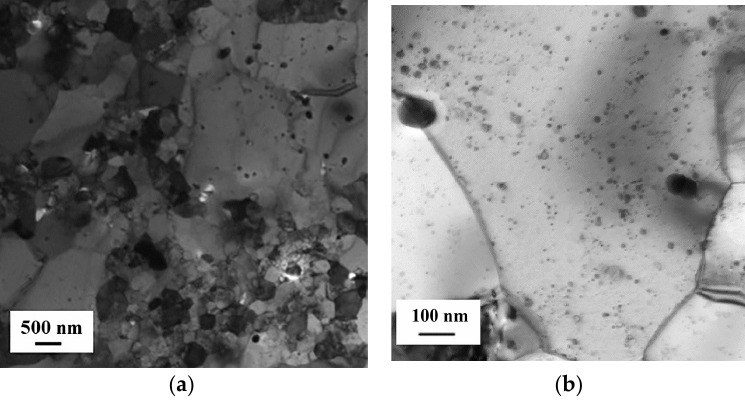
Figure 6. TEM micrograph of ODS sample after heat treatment at 1150 °C for 30 min. ( a ) Bimodal grain size distribution. ( b ) Nanosized precipitates inside a ferritic grain of small size.